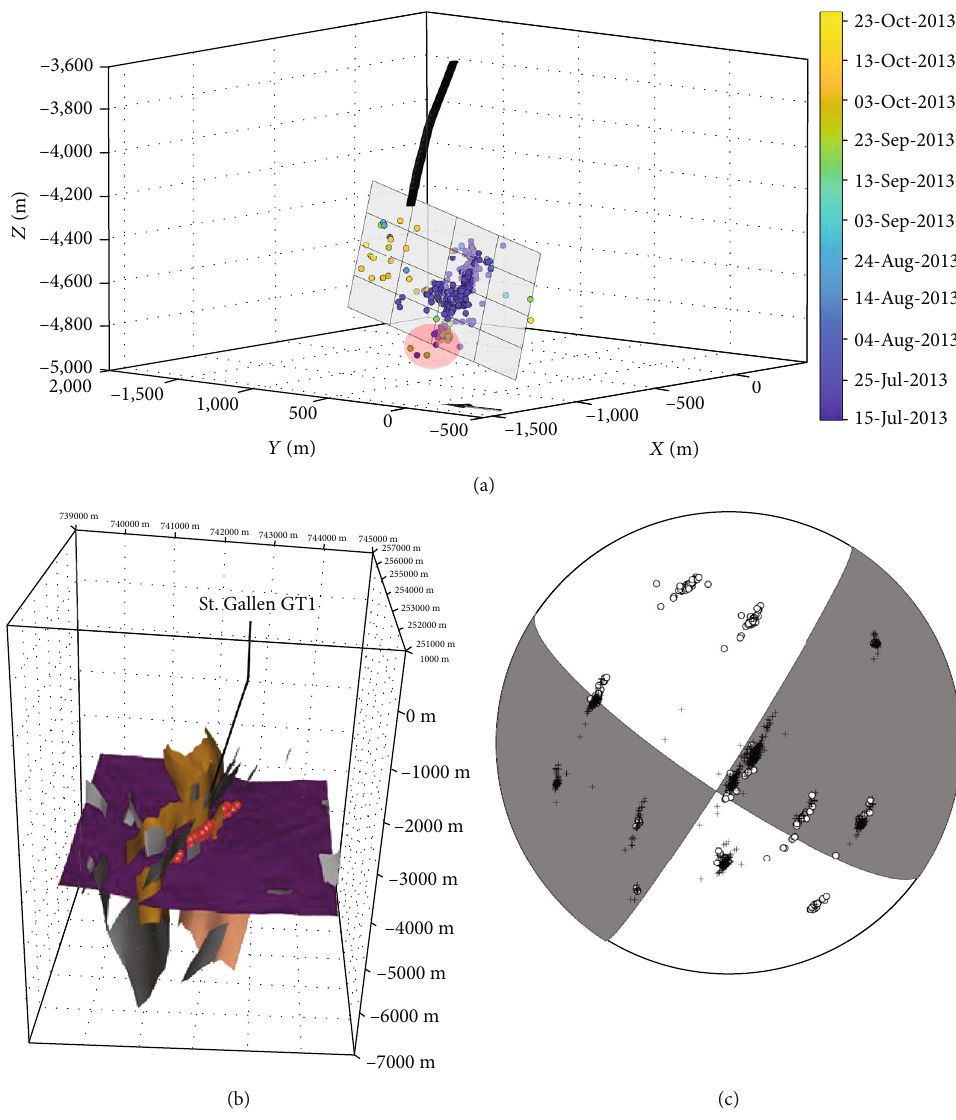
Figure 1: (a) Time-encoded relative hypocentre locations in perspective view with best- fi tting plane determined by linear regression. Trajectory of St. Gallen GT-1 is indicated by a black line. Red shaded area denotes presumably falsely located event cluster (see Induced Seismicity above). Coordinates are given with respect to the top of GT-1 (47.415200 ° N 9.328801 ° E). (b) The structural model of St. Gallen displaying the well path of the geothermal well (black line), top Palaeozoic (violet) and faults (as interpreted from the 3D seismic survey [9]) as well as hypocentres of the induced seismicity (from the Swiss Seismological Service (SED), red dots). View from northeast. (c) Earthquake source-centred, stereographic projection (lower hemisphere) of P -wave polarity data for all 347 events. The beachball indicates the compound fault plane solution and is approximately similar to the largest event ( M L 3.5) determined by Diehl et al. [16] with strike/dip/rake-values of 124 ° /72 ° /174 ° ,